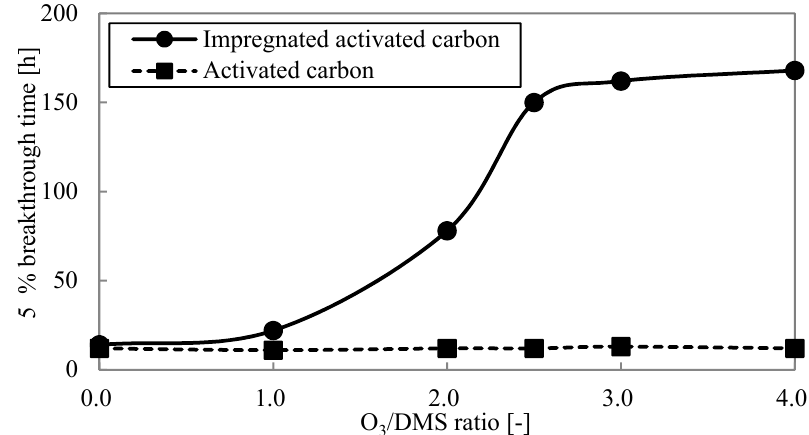
Figure 9. The dependence of 5% breakthrough time on O 3 /DMS.